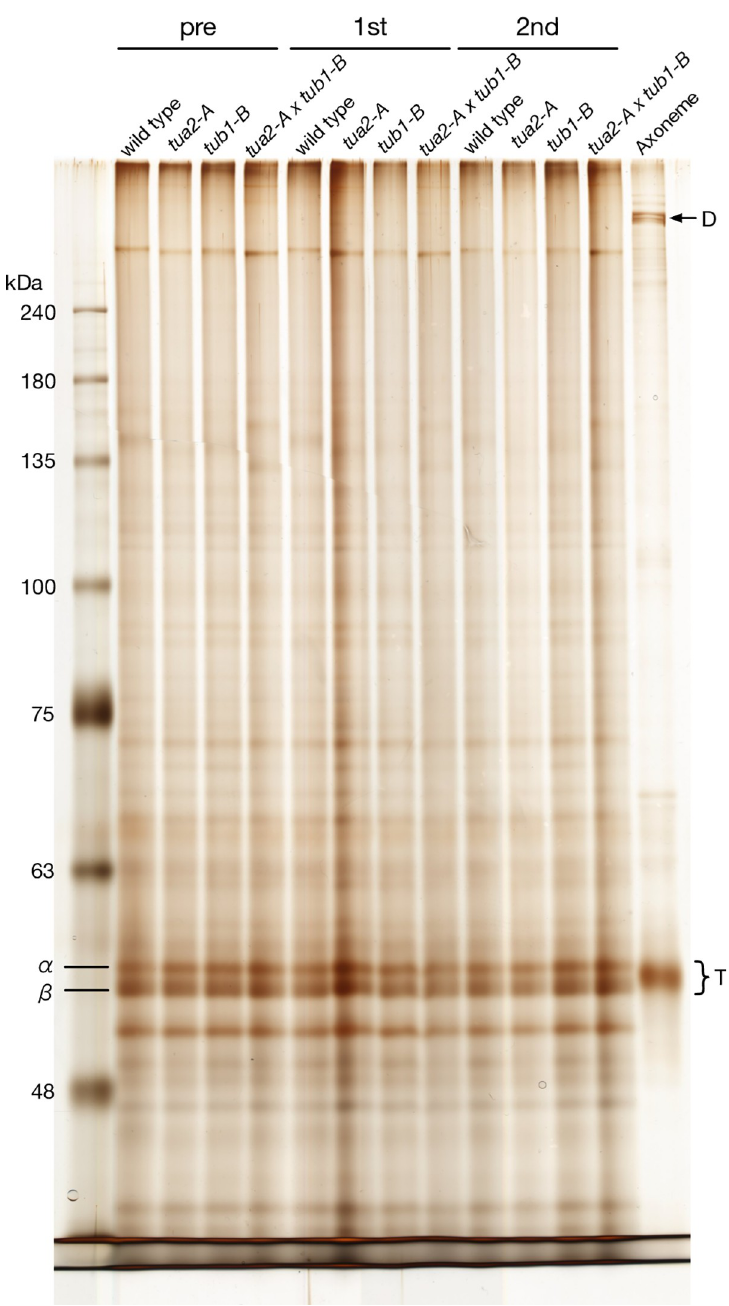
Fig 3. Tubulin protein expression in the tubulin-gene disruptants. All of the disruptants showed tubulin expression at the normal level. Whole-cell lysates from wild type (CC-125), tua2-A , tub1-B , and a tua2-A x tub1-B double mutant were prepared before deflagellation (pre), after the 1st deflagellation (1st), and after the 2nd deflagellation (2nd) and electrophoresed. Wild-type axoneme (Axoneme) was loaded for comparison. D indicates bands with axonemal dynein heavy chains (~500 kDa). T indicates α and β